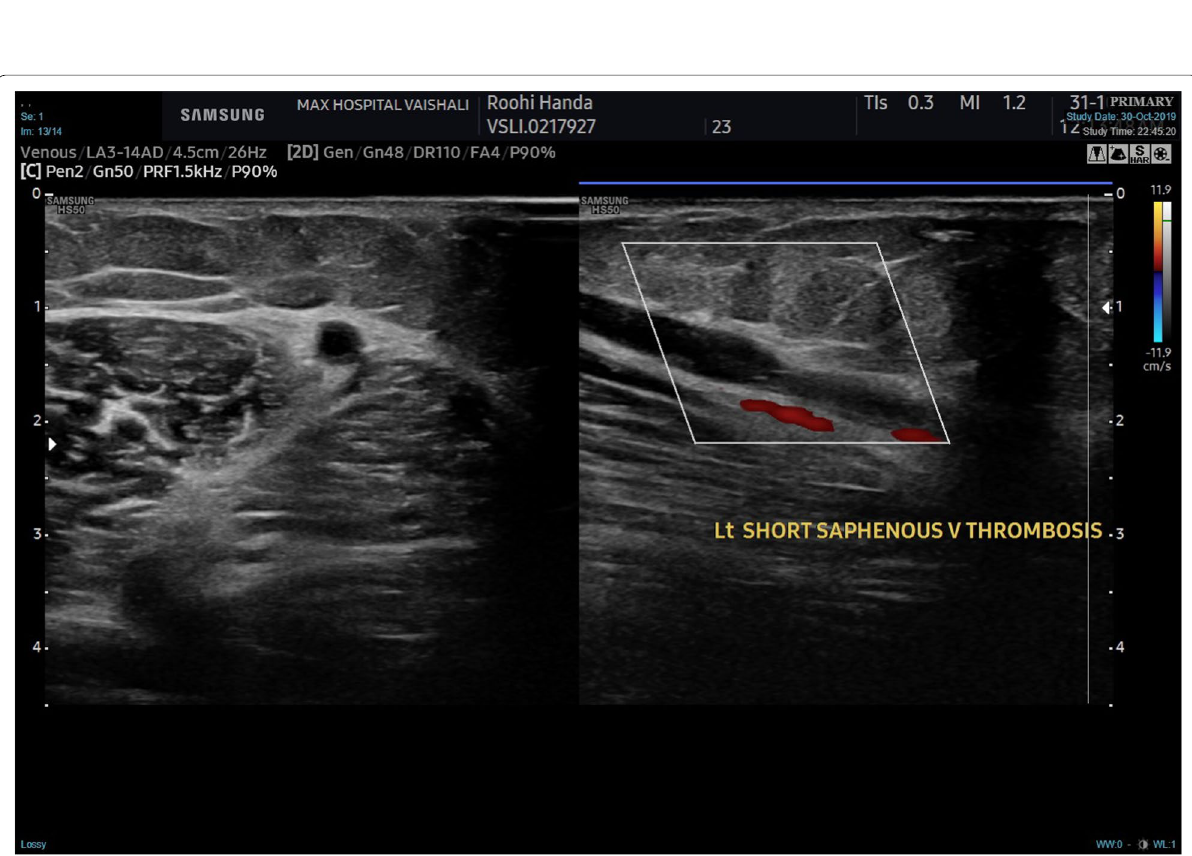
Fig. 8 Venous Doppler of the lower limb revealed deep vein thrombosis involving left common, external iliac, common, superficial and deep femoral, and popliteal veins with